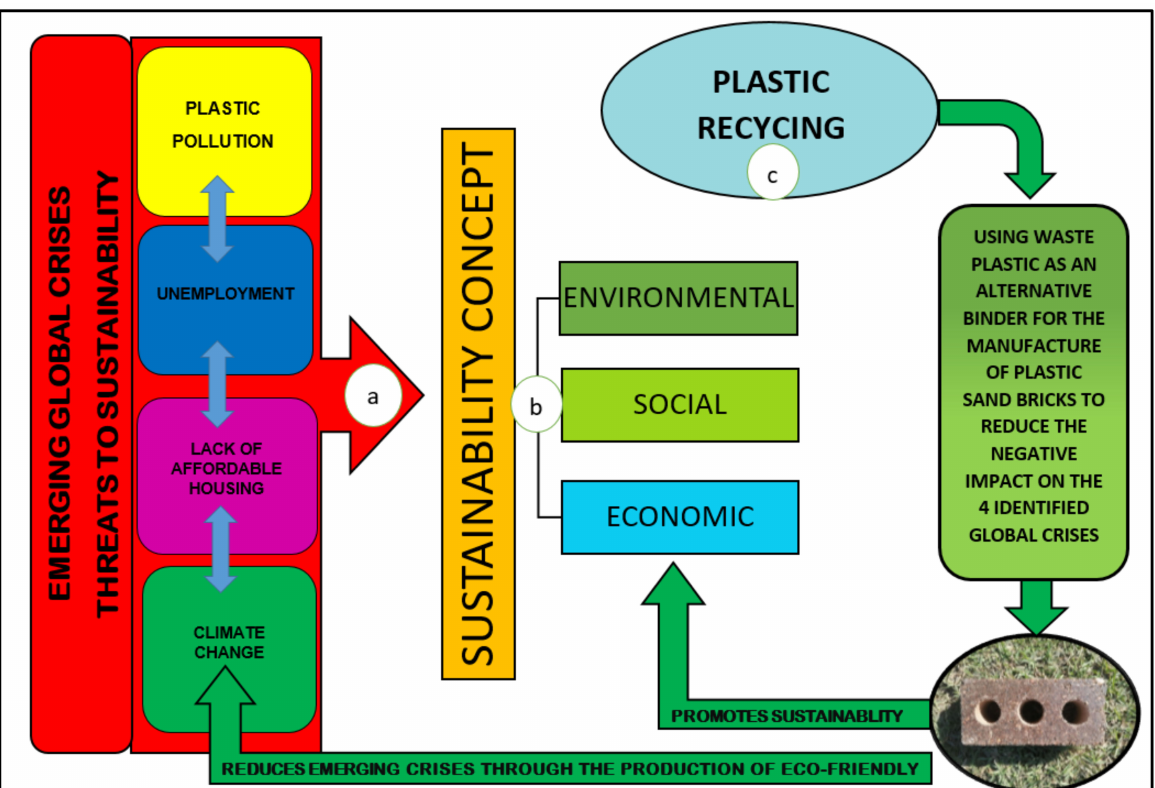
Figure 3. Plastic recycling as a solution to reducing emerging global